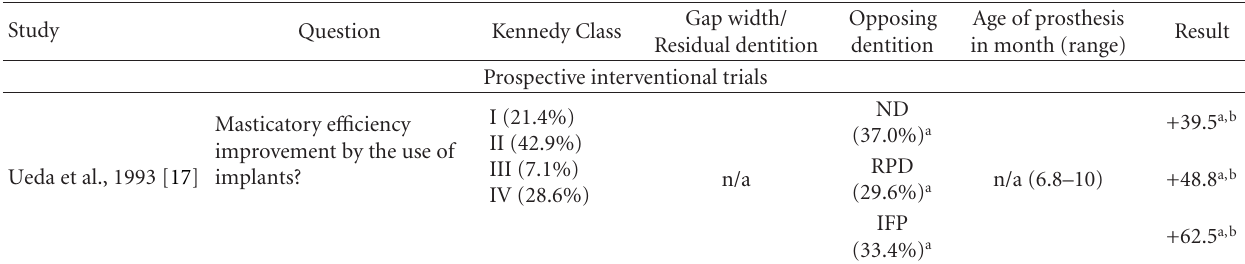
Table 7: E ff ect of fixed denture on eating